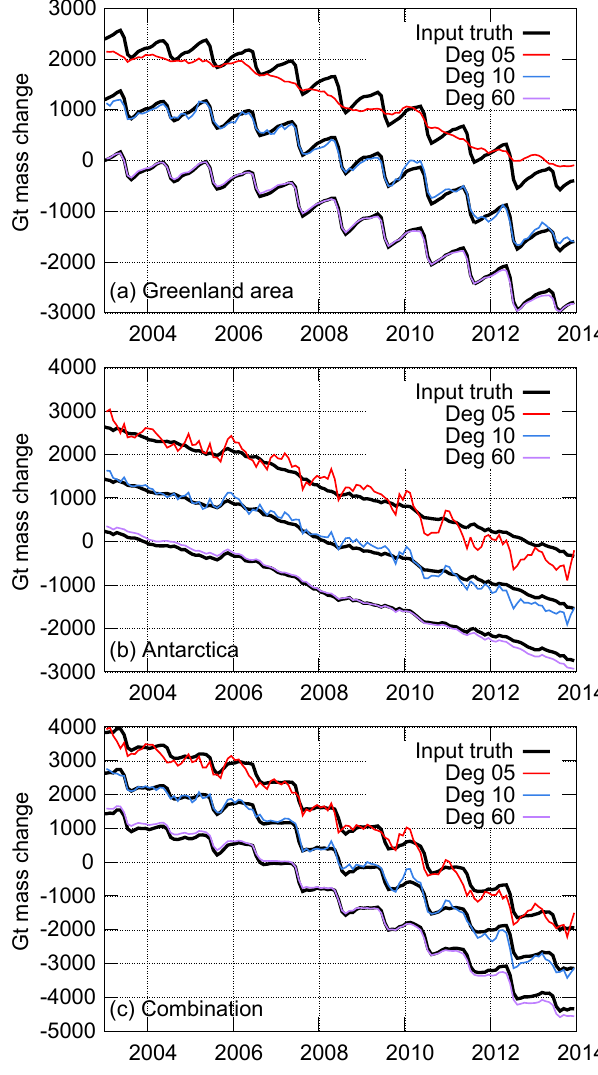
Figure 2. Simulated inversion results by maximum degree/order, relative to input “truth” signal. Regions considered are (a) Green- land and surrounding islands, (b) Antarctica, and (c) the sum of Greenland and Antarctica. Each inversion was run using correlation-based constraints. Time series are offset for